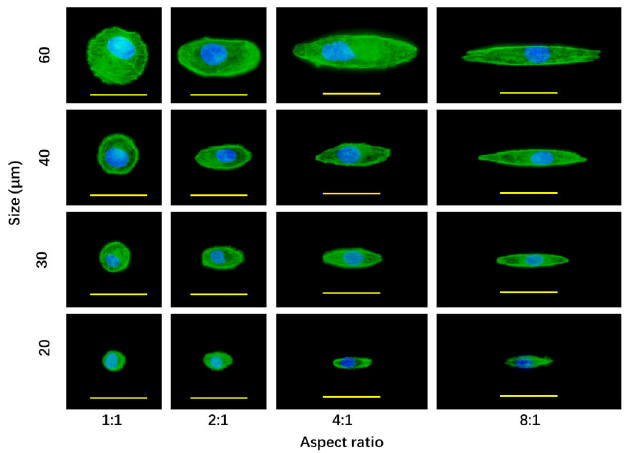
Figure 5. Fluorescence photomicrographs of actin filament staining of breast cancer cells after culture on the micropatterned surfaces for 24 h. Actin filaments and nuclei were stained green and blue, respectively. Scale bar = 50 µ m.